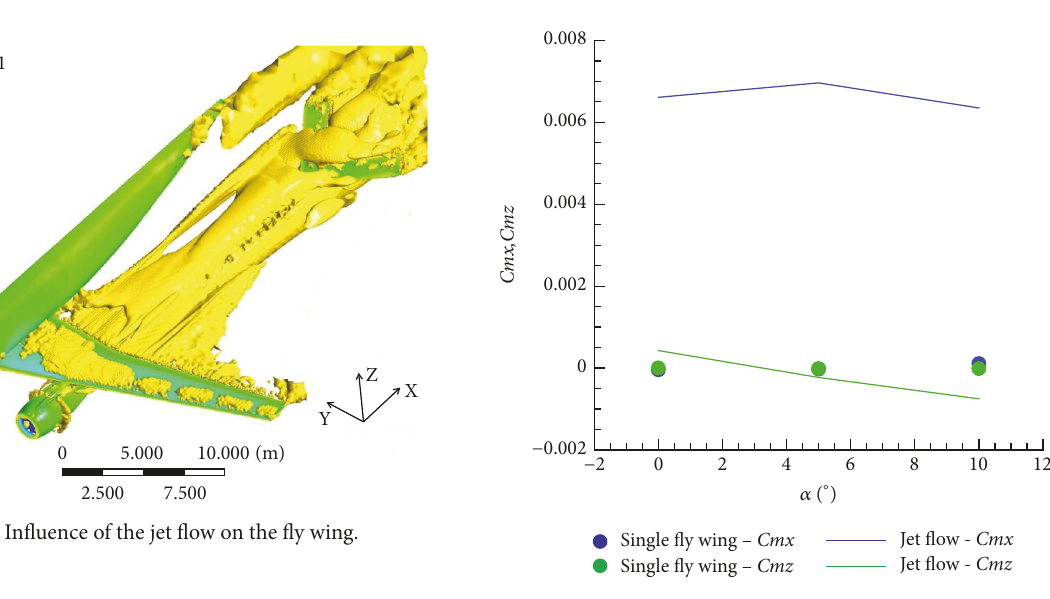
Figure 14: Steady aerodynamics, rolling moment coefficients Cmx and yawing moment coefficients Cmz .